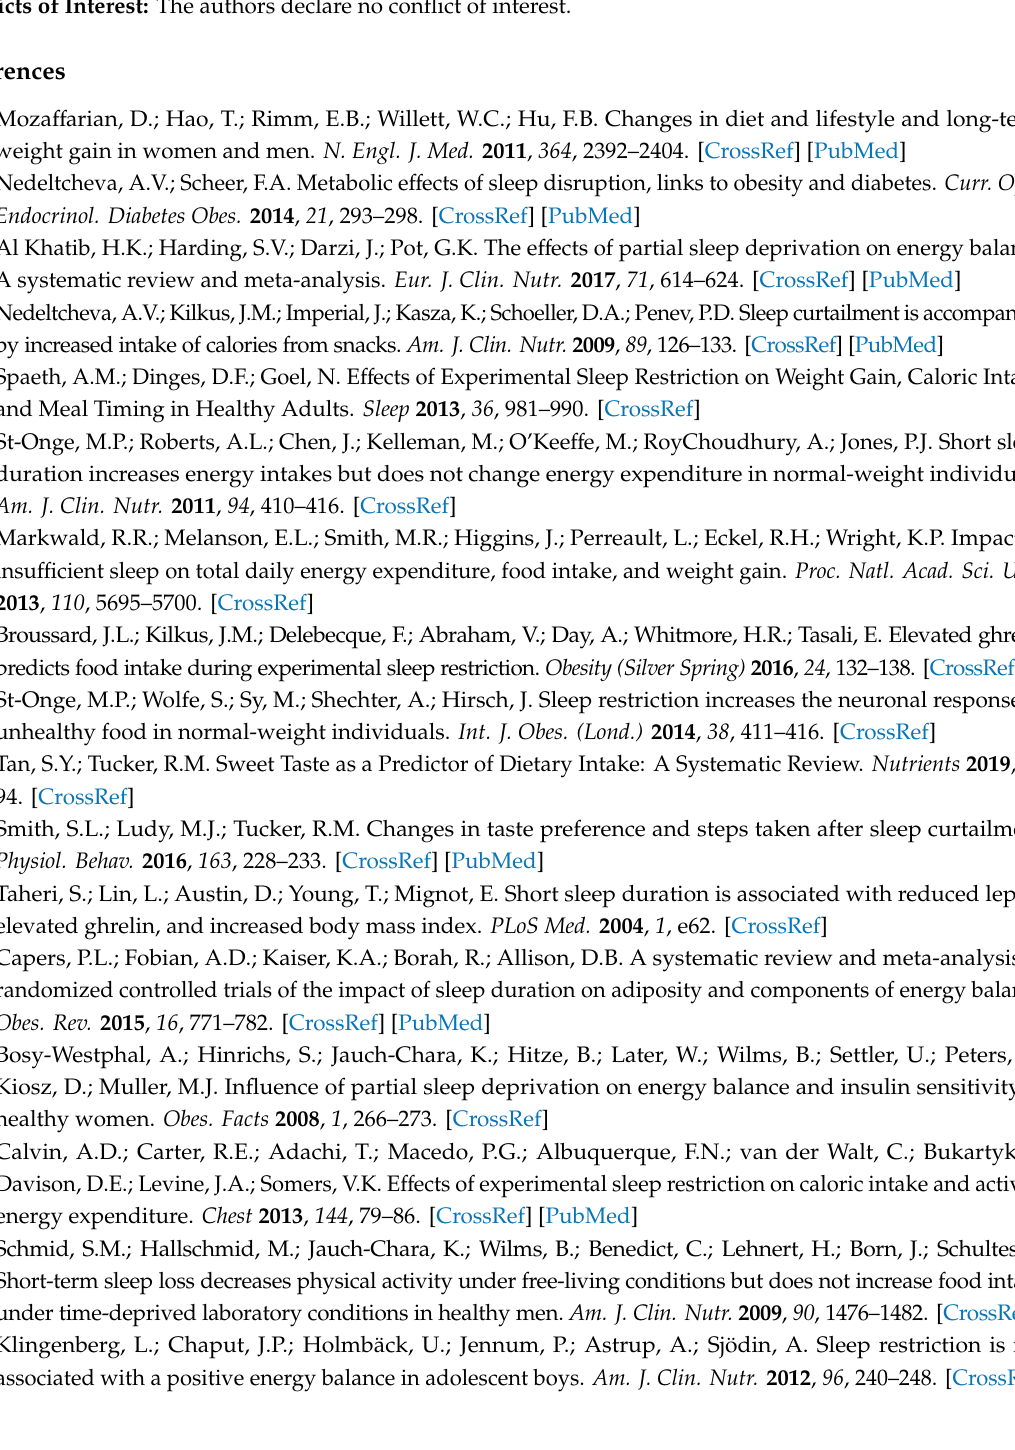
Table S1: nutritional component of Ad libitum